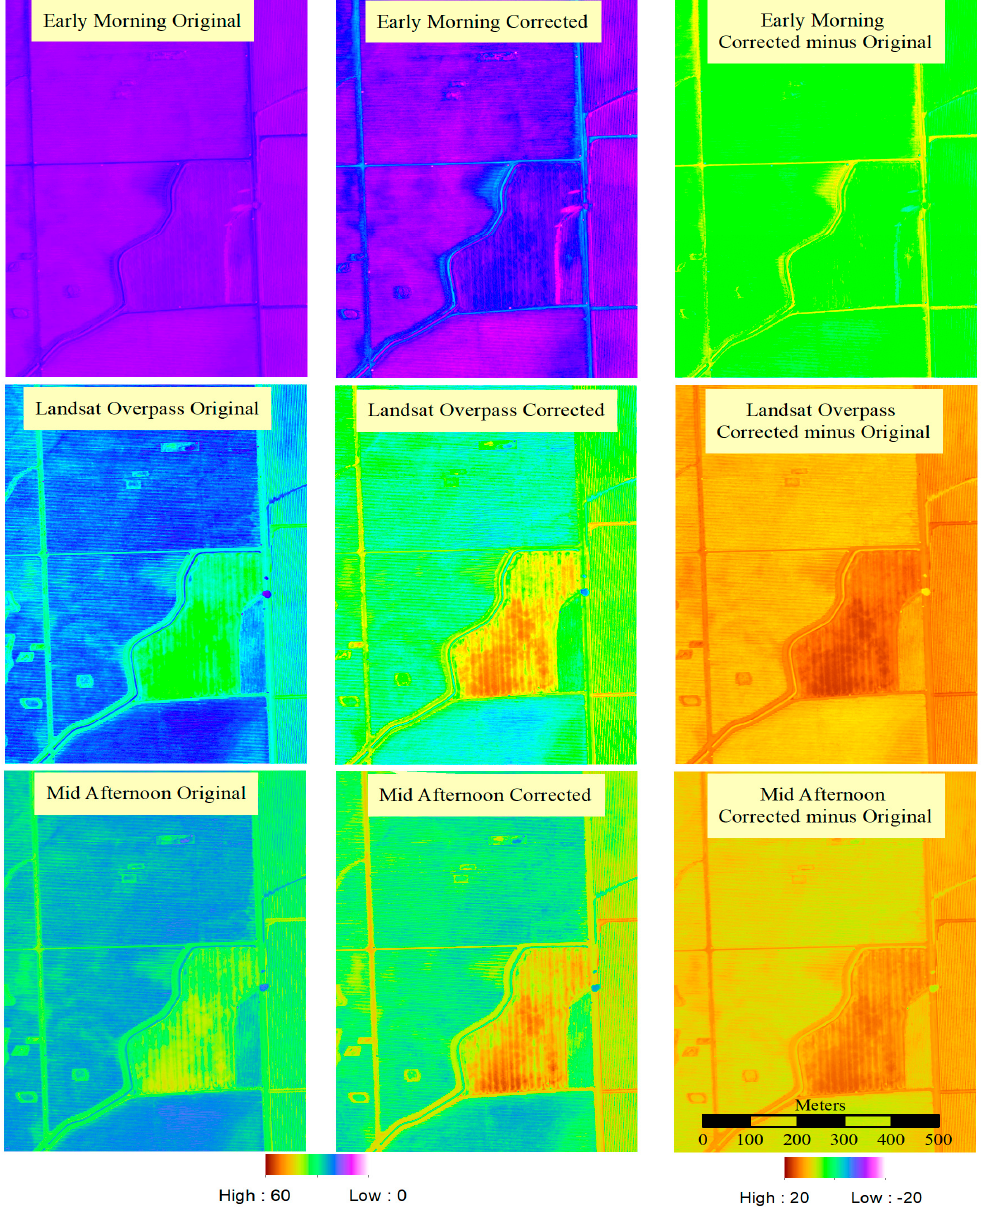
Figure 10. An example of temperature image correction for 2 May 2016 using the vicarious calibration for early morning ( top row ), Landsat overpass ( center row ) and mid-afternoon ( bottom row ). Units in Celsius. The left column is the sUAS original temperature image, the center column is the original sUAS image after the atmospheric radiance correction, and the right column is the difference between the corrected minus original sUAS imagery.